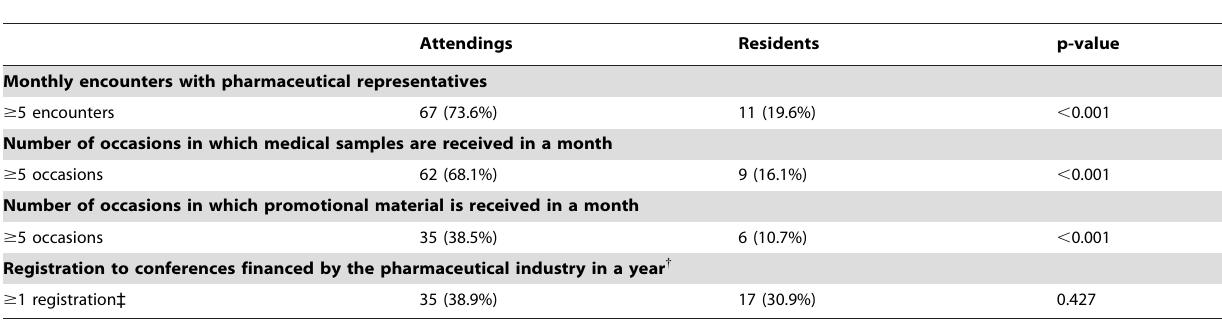
Table 3. Participation in activities and acceptance of gifts from industry stratified by position (attendings vs. residents).